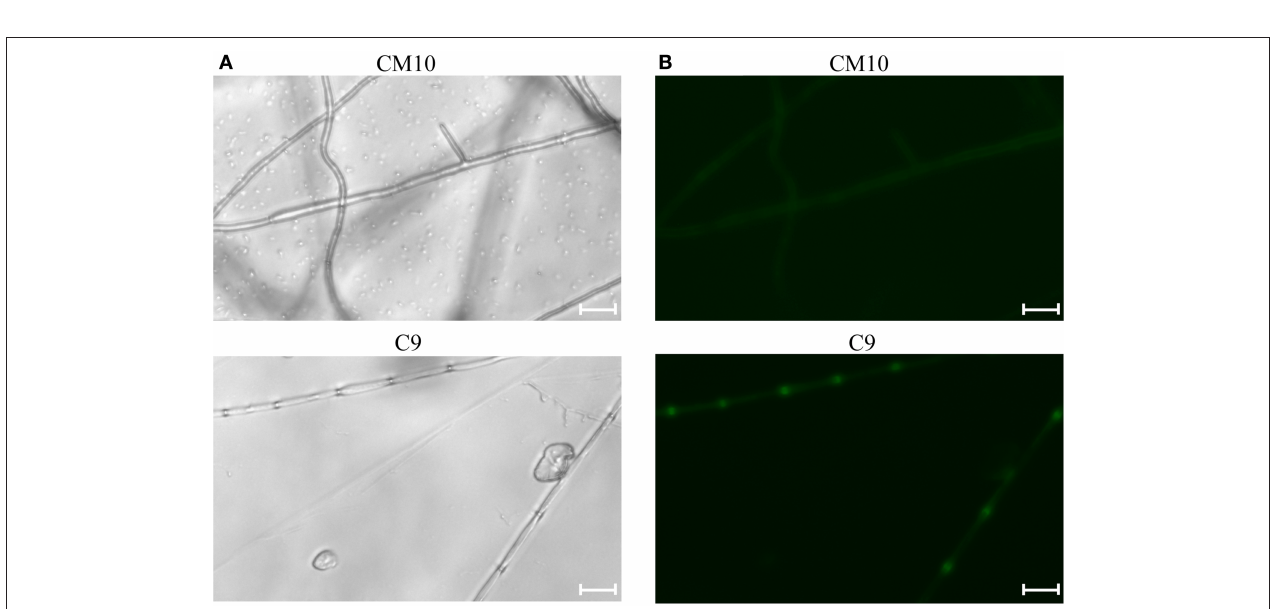
FIGURE 3 | Detection of Cas9-expressing transformants. (A) Nucleic acid gel electrophoresis analysis of putative Cas9 transformants (Expected target band was 491 bp). (B) Western blot for Cas9 detection (S1–S5 represented putative transformants; CM10 represented the negative control; the expected Cas9 band was 186.5 kDa and is indicated by arrows).